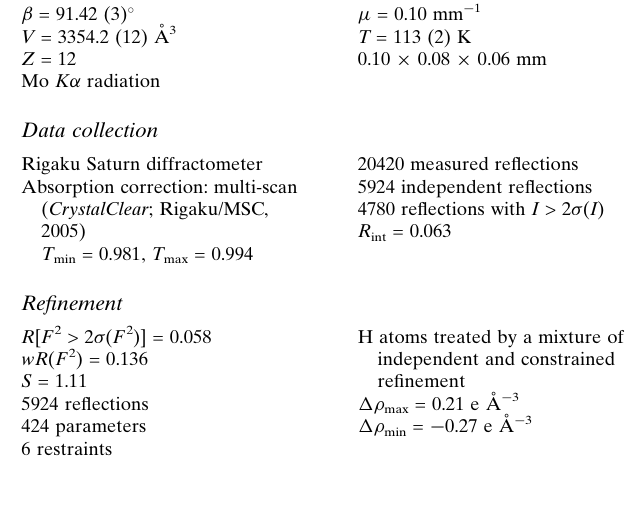
The title compound, C molecules in the asymmetric unit. The cyclohexane ring adopts a chair conformation. Intermolecular O—H (cid:1) (cid:1) (cid:1) O hydrogen bonds are observed and these help to establish the crystal packing.